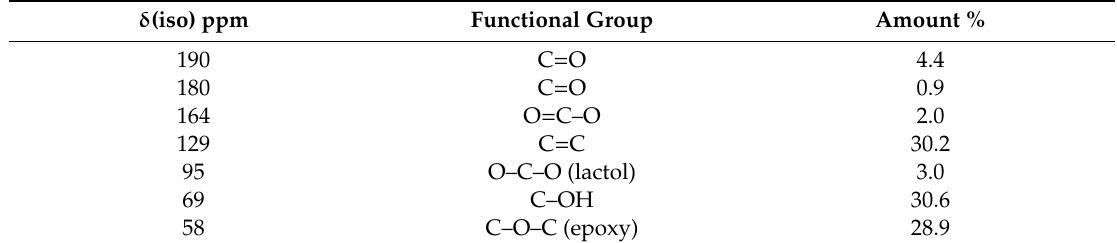
Table 1. Assignment and amount of the main identified peaks [15,16] calculated from the profile fitting of the 13 C MAS spectrum of Ga (Figure S1, Electronic Supplementary Materials).